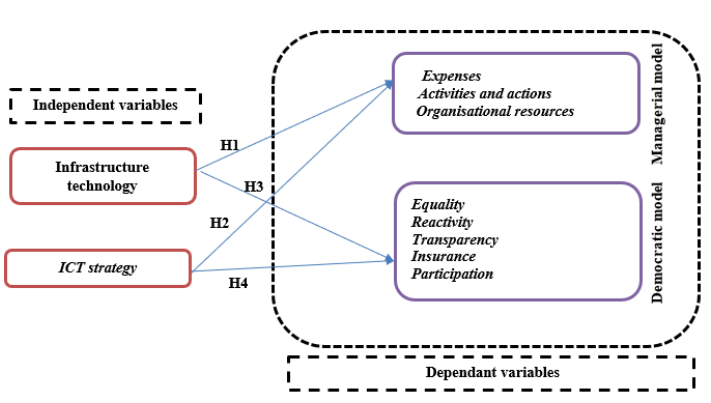
Figure 4. Conceptual model (source: author